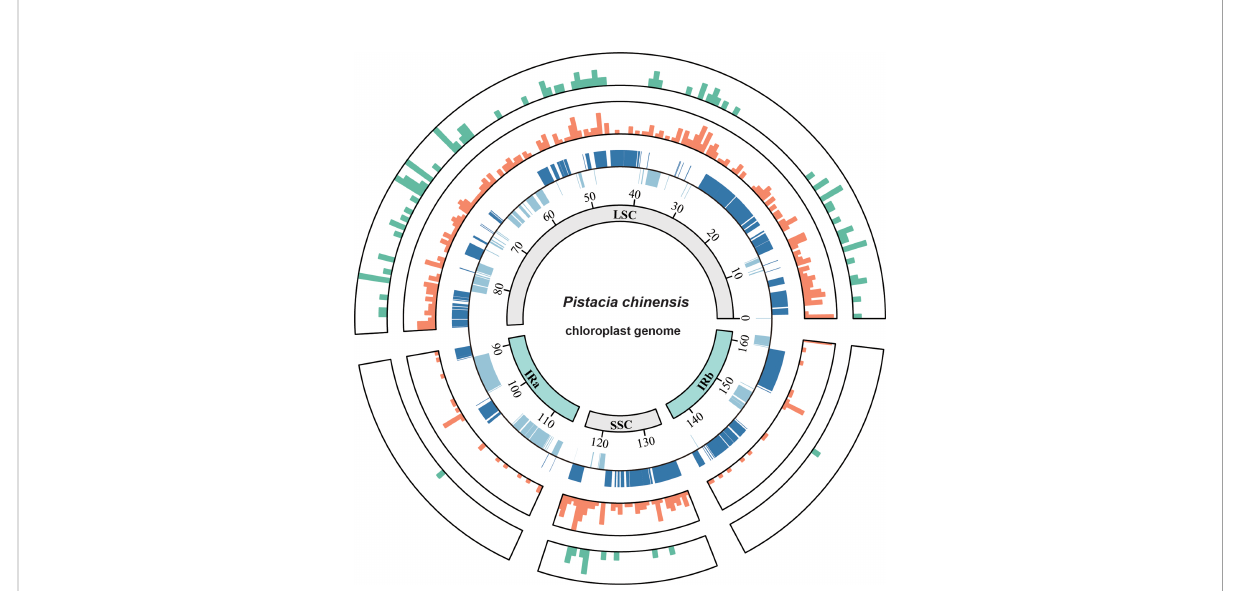
FIGURE 1 Circos plot showing the indel and nucleotide diversity of the Pistacia chinensis plastome. The concentric circles (inner to outer) indicate the following: quadripartite structure (represented by different colors); location of genes in the plastome; nucleotide diversity; and the number of indels. Nucleotide diversity and number of indels were computed for windows of 500